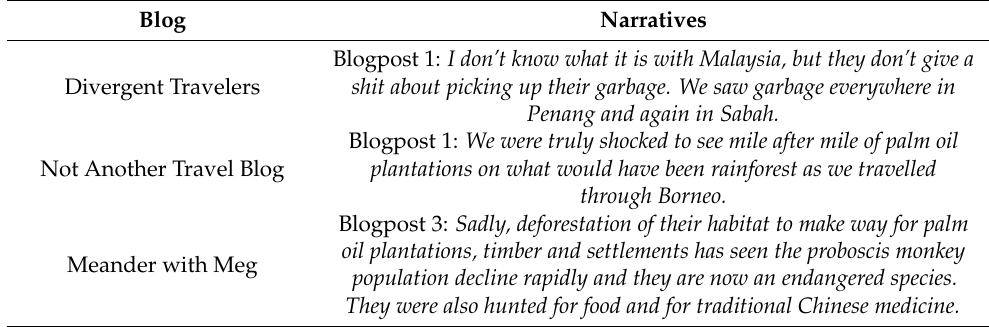
Table 5. Emotional Narratives on Theme Environment.